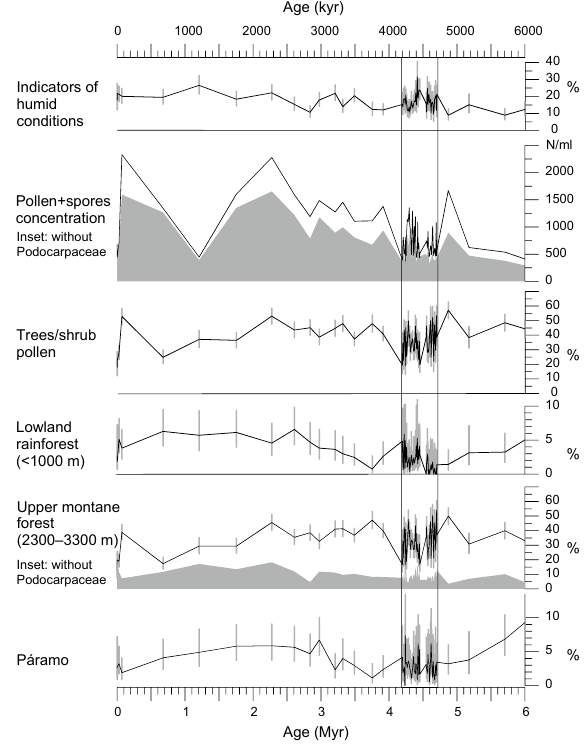
Figure 3. Pliocene and Pleistocene palynomorph percentages (based on the total of pollen and spores) of ODP Hole 1239A for three vegetation belts, humidity indicators, grass pollen, and pollen and spore concentration per milliliter. 95% confidence intervals as grey bars after Maher (1972). Age model for the last 5Myr after Tiedemann et al. (2007) and for 6 to 5Myr after Mix et al.